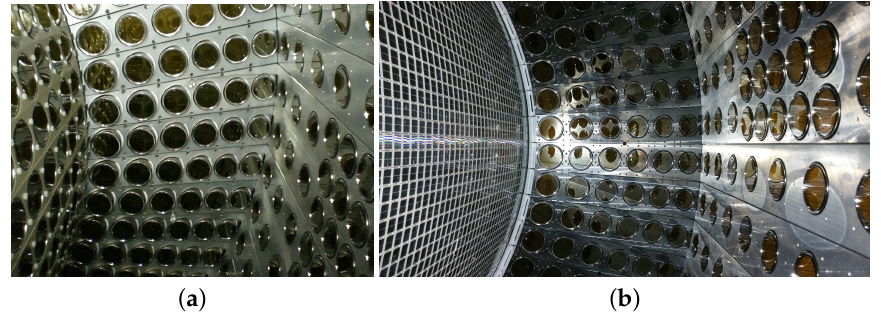
Figure 4. ( a ) Picture of photo-sensors mounted on inner faces of the ( a ) MEG and ( b ) MEG II liquid xenon